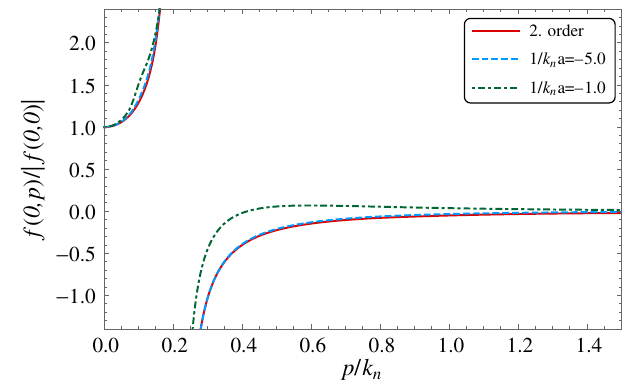
¼ B ¼ 0 . 2 , a n B